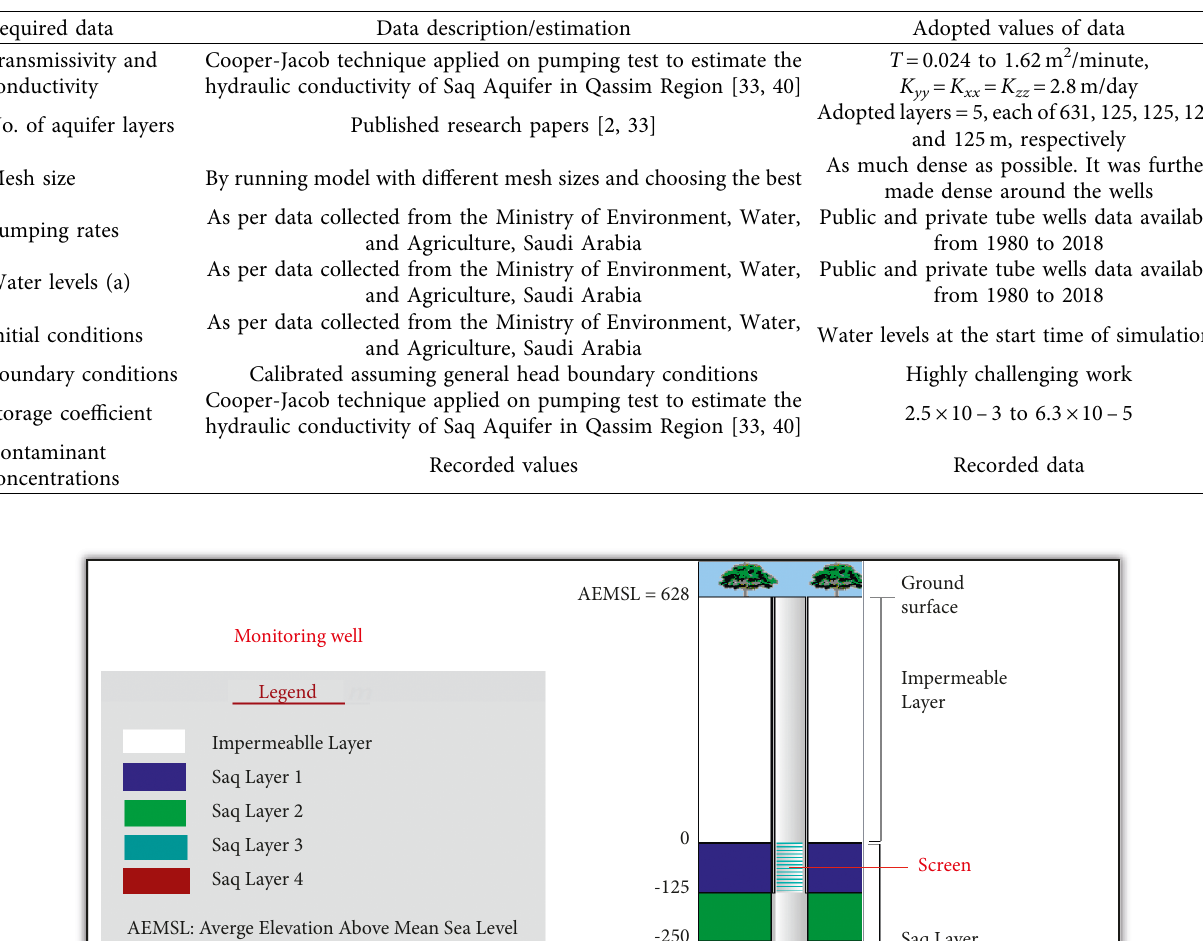
Table 3: Input values of data for MODFLOW.